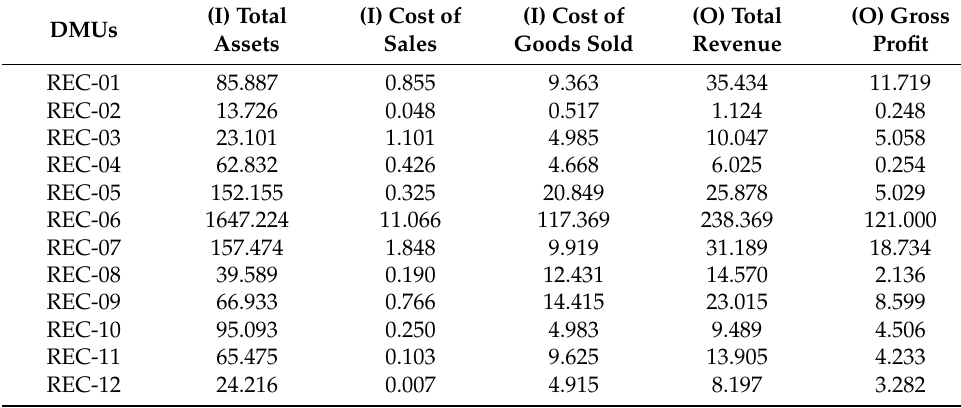
Table A3. The historical data of the year 2017, (unit: million USD).